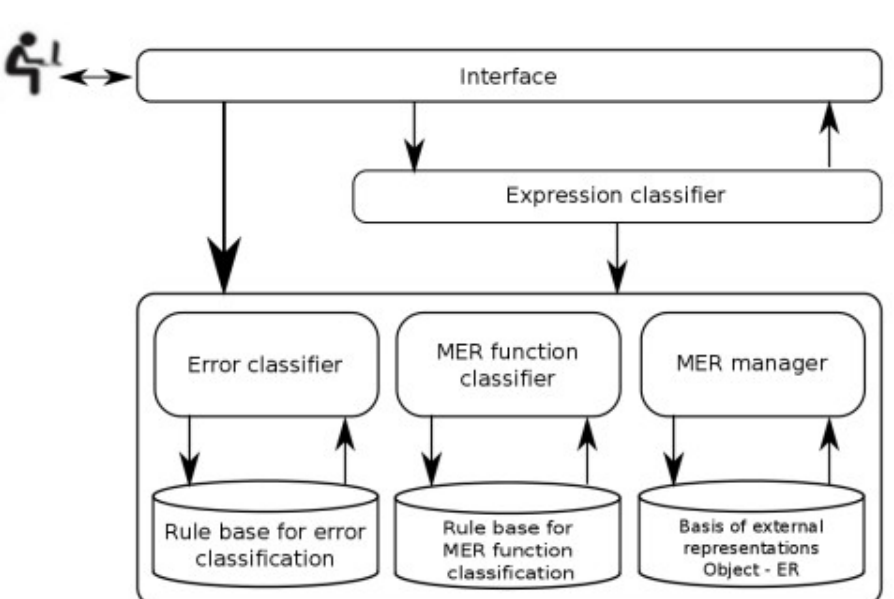
Figure 1. Conceptual framework for using MERs in error remediaton applied to learning